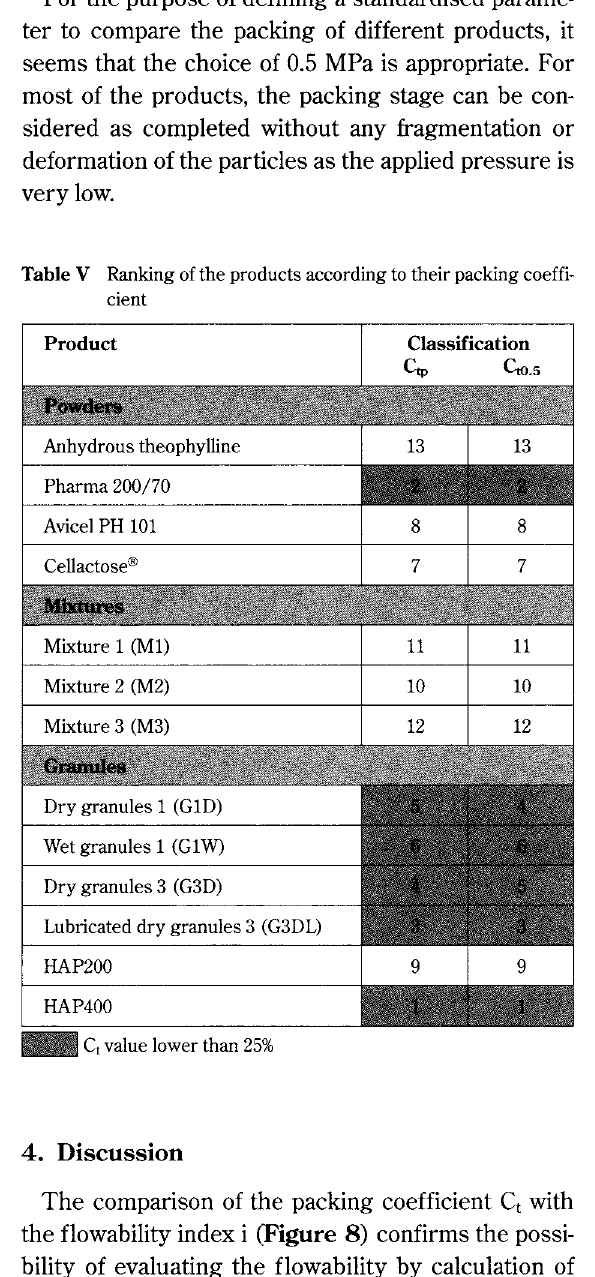
Fig. 8 Flowability index (i) and packing coefficient (CJ calcu <•l lated at 0.5 MPa or at the pressure P corresponding to the slope change (D)